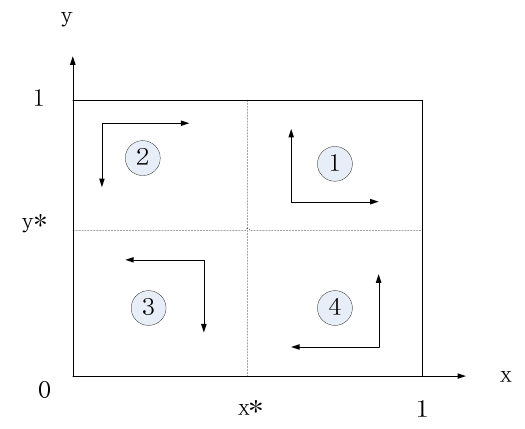
Figure 4. Evolutionary game